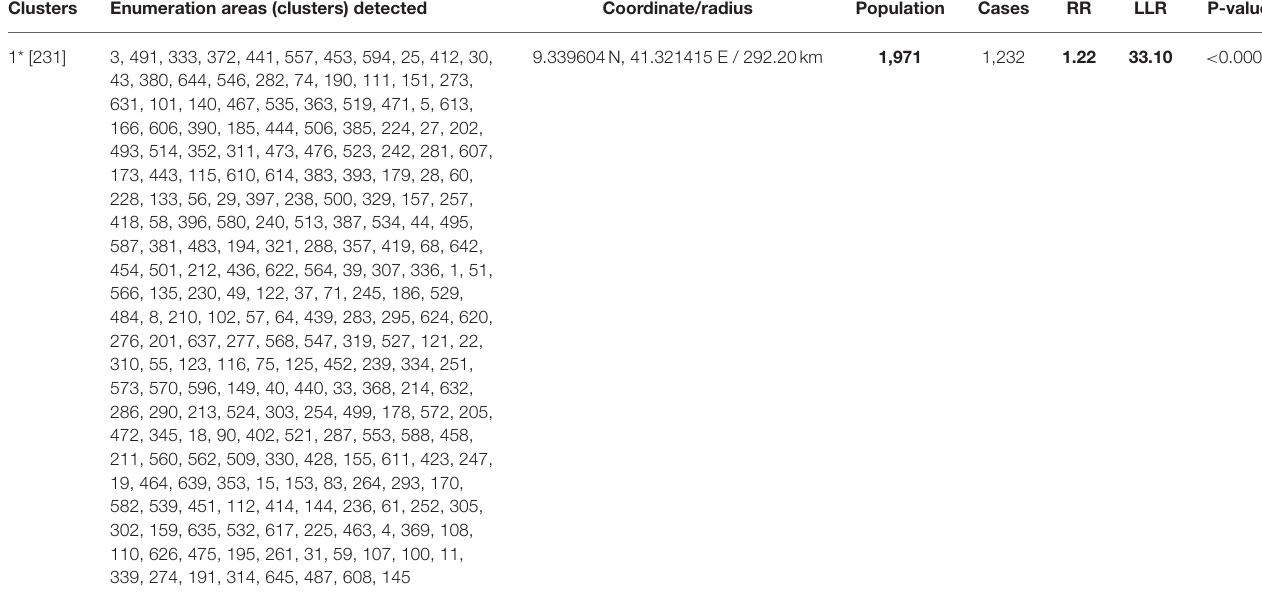
TABLE 5 | Significant spatial clusters of resumption of post-partum menses among women in Ethiopia, EDHS 2016 data. Clusters Enumeration areas (clusters)